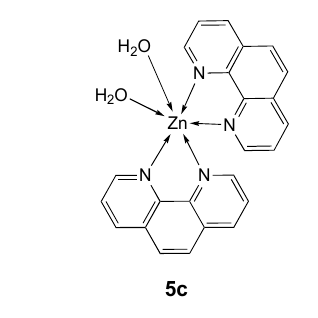
Figure 3. Structure of the zinc complexes 5a – c .